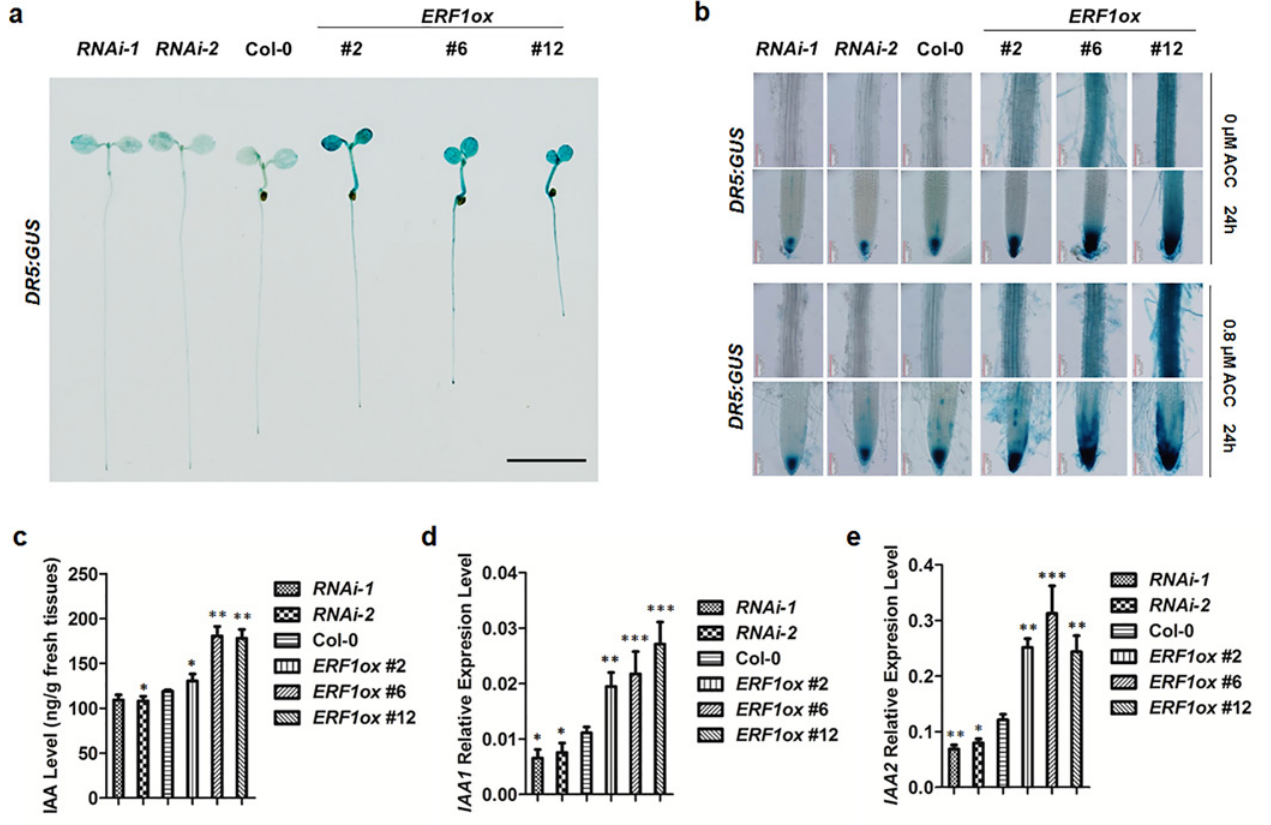
Fig 3. ERF1 enhances auxin accumulation in roots. ( a ) DR5 : GUS expression in 5-day-old seedlings of Col-0, ERF1 knockdown ( RNAi-1 , RNAi-2 ) and overexpression lines ( ERF1ox #2 , ERF1ox #6 , ERF1ox #12 ). Three independent experiments were done, and each replica containing 15 plants for each line. Representative seedlings were photographed. Scale bar, 0.5 cm. ( b ) DR5 : GUS expression in maturation region and root tip of primary root. Five-day-old seedlings of Col-0, ERF1 knock-down ( RNAi-1 , RNAi-2 ) and over-expression ( ERF1ox #2 , ERF1ox #6 , ERF1ox #12 ) lines were treated with 0 or 0.8 μ M ACC for 24 h before GUS activity was assayed. More than 20 plants were observed for each line. Representative photos were displayed. ( c ) Free IAA content. Seeds of ERF1 overexpression and RNAi lines were grown on MS plates for 5 d before root IAA content was measured. The mean ± SD of three replicas is shown ( * P < 0.05, ** P < 0.01). Asterisks indicate Student ’ s t-test significant differences. ( d-e ) The transcript level of IAA1 and IAA2 . Seeds of ERF1 overexpression and RNAi lines were grown on MS plates for 5 d before RNA isolation from the roots. Transcript abundance of IAA1 and IAA2 was measured using qRT-PCR. The mean ± SD of three replicates is shown ( * P < 0.05, ** P < 0.01, *** P < 0.001). Asterisks indicate Student ’ s t-test significant